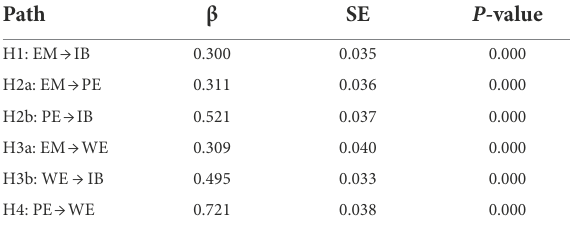
TABLE 4 Studies the direct impact of pathways.